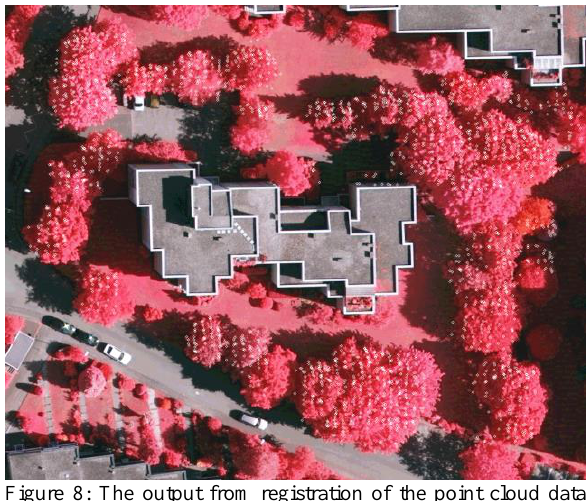
Figure 8: The output from registration of the point cloud data on the image after applying the corrections.